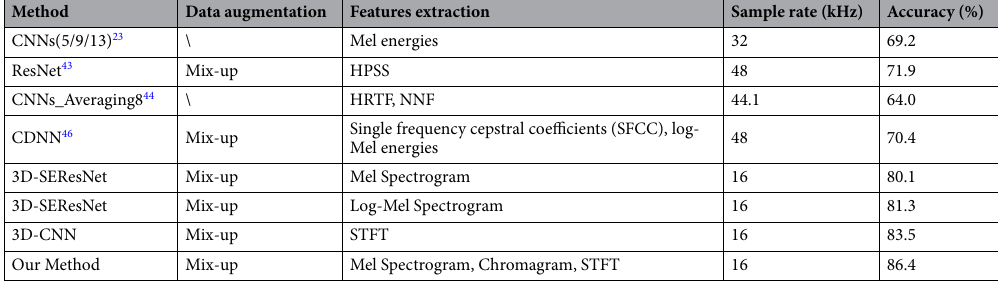
Table 1. Classification accuracy of various